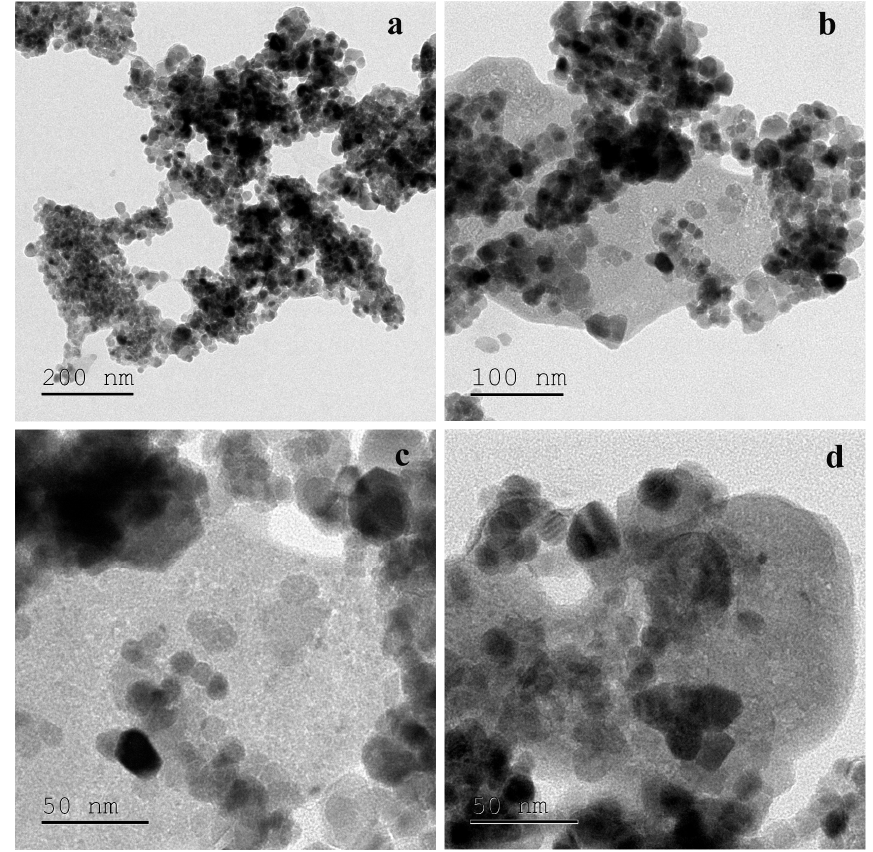
Figure 3. TEM image of nano-ZnO particles using C. verrucosa leaf extract at di ff erent scale: ( a ) 200 nm, ( b ) 100 nm, ( c , d ) 50 nm.